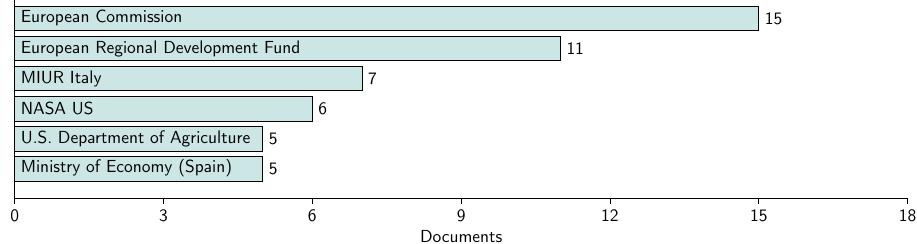
Figure 18. Popular funding sponsors with the most publications on adopting